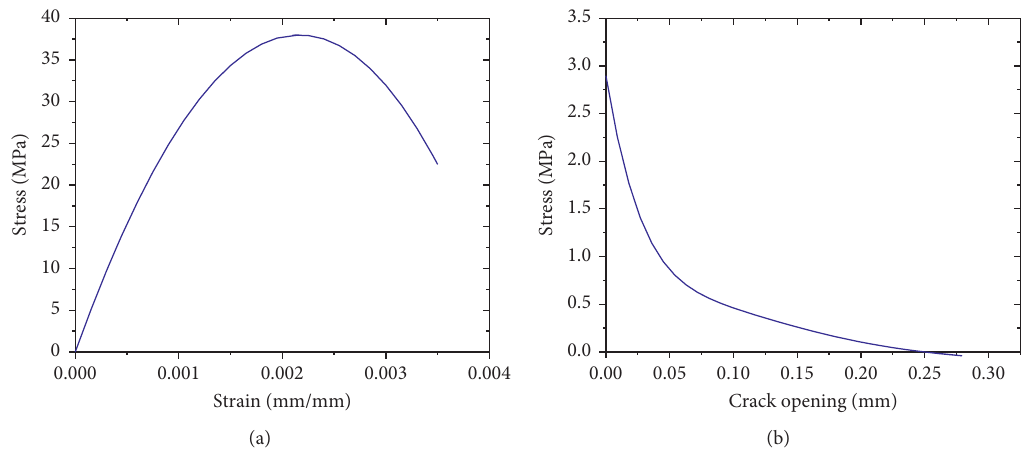
Figure 5: Concrete material response: (a) compressive stress-strain relation; (b) postfailure tensile behavior.